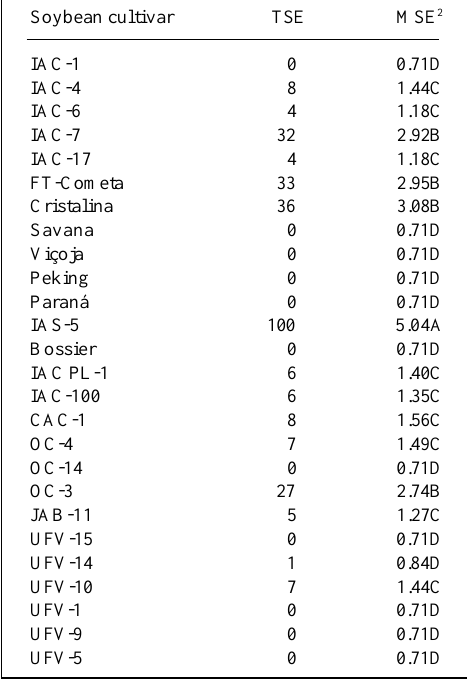
Table III - Total (TSE) and mean (MSE) number of somatic embryos (x + 0.5) 1/2 derived from each soybean cultivar (F-test = 25.37 1 ; C.V.% = 15.78). Soybean